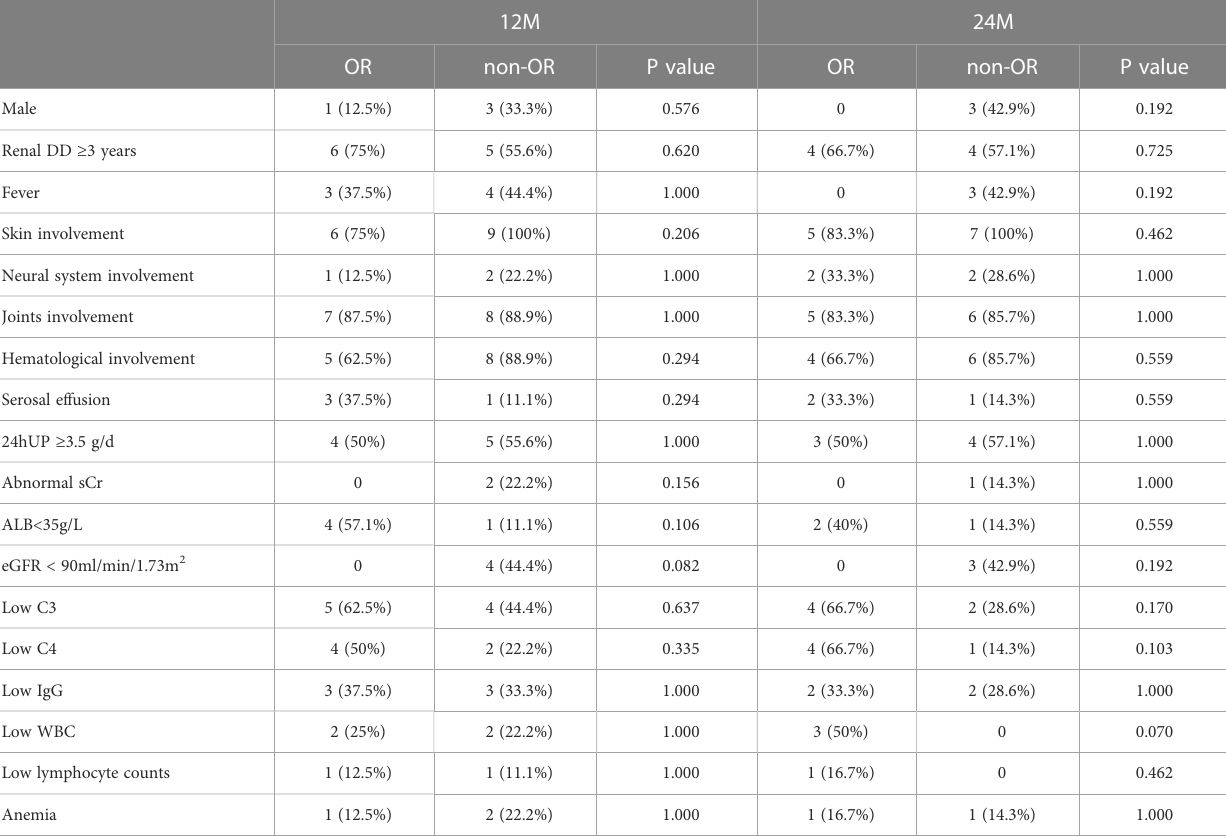
TABLE 2 Factors related with OR at 12 months and 24